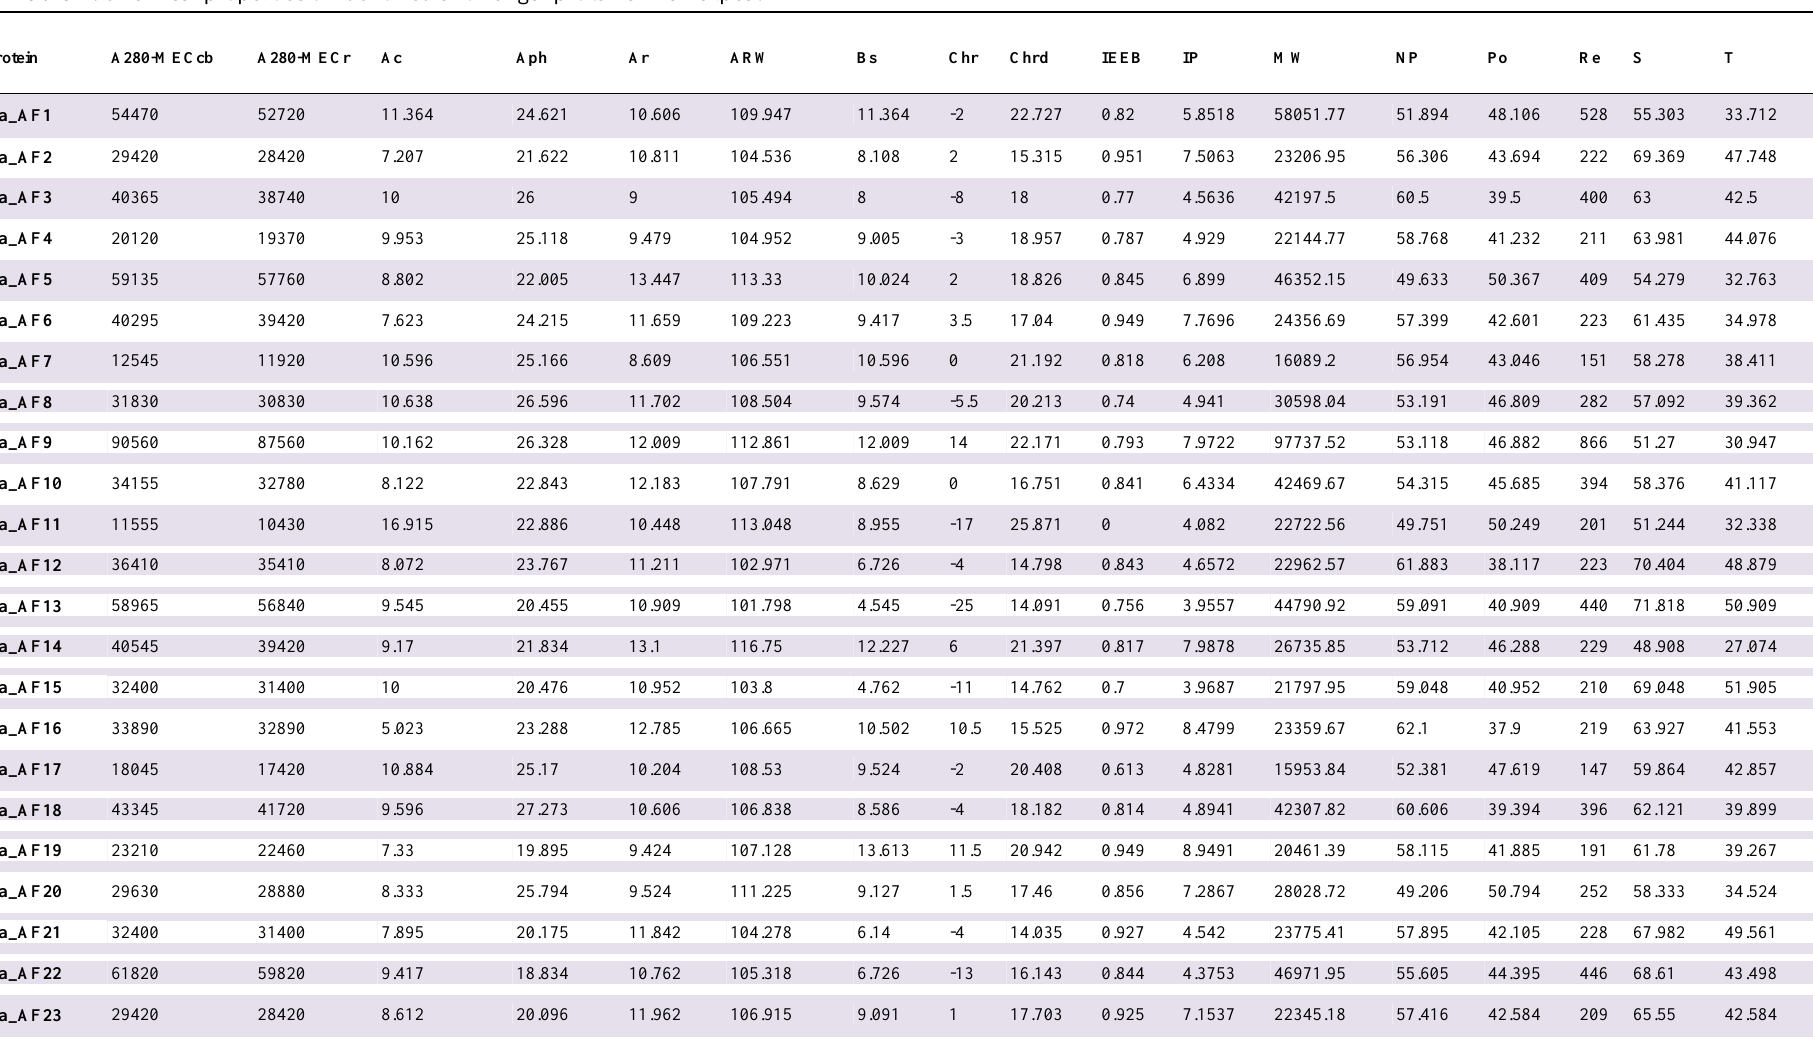
Table 2 : Chemical properties of identified anti-fungal proteins in chickpea.